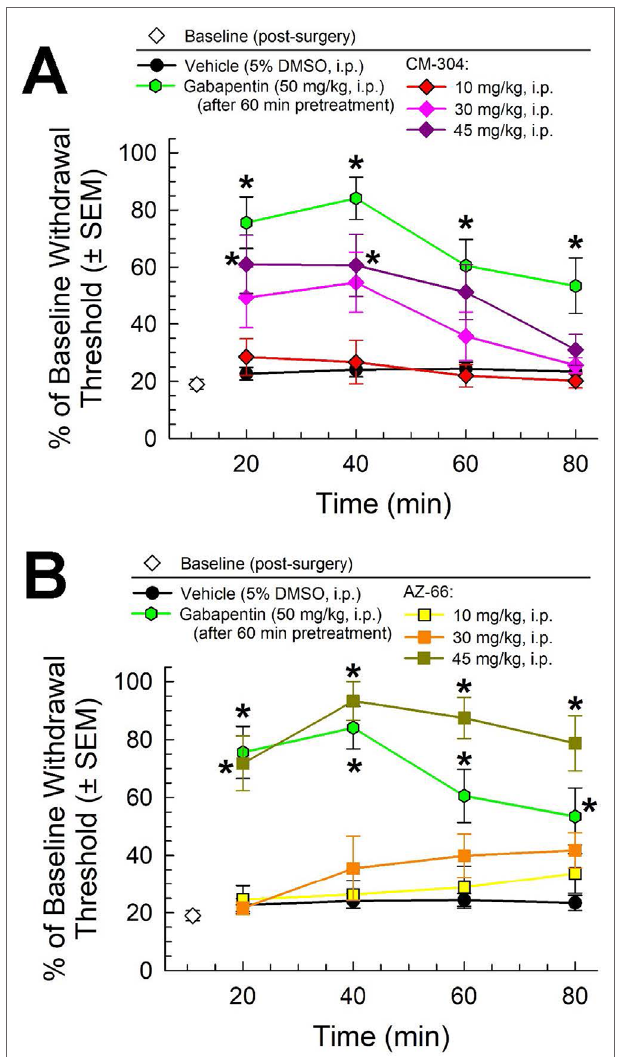
FIGURE 3 | Dose- and time-dependent antiallodynic activity of (A) CM-304 (diamonds) and (B) AZ-66 (squares) in the mouse chronic constriction injury (CCI) assay. Gabapentin (green hexagons, 60-min pretreatment) is included as a positive control; vehicle (5% DMSO; black circles) is included as a negative control. * = significantly greater than vehicle effect, p < 0.05; two-way ANOVA w/Tukey post hoc test. N = 8–10 mice treated with a single dose of sigma receptor antagonist and 11 mice for